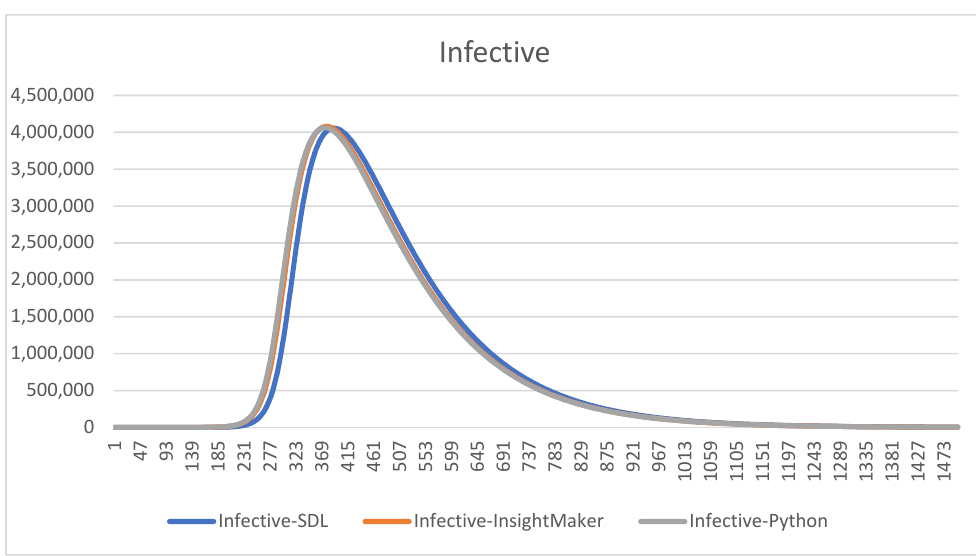
Figure 11. Comparison chart for Infective.